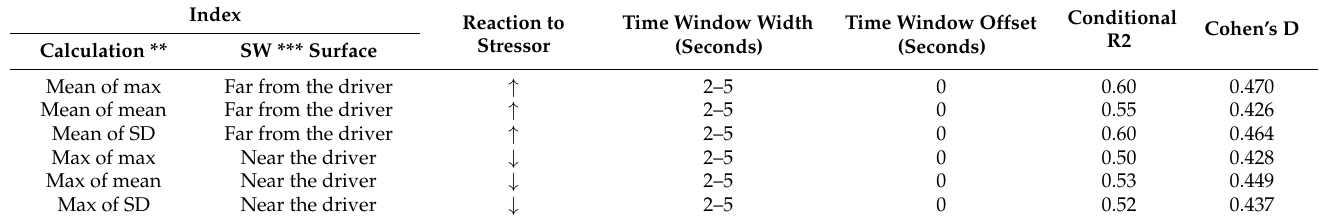
Table 2. Grip force calculations for each steering wheel surface, as affected by the stressor